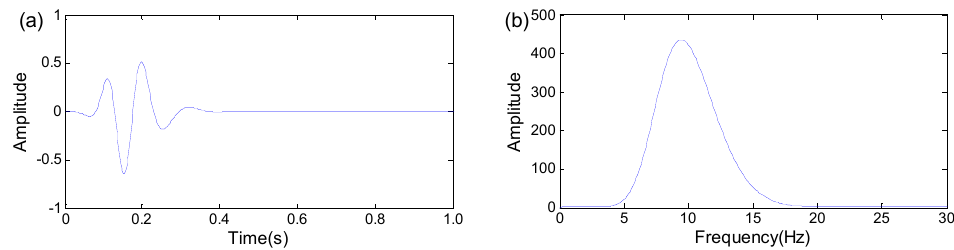
Figure 5. Source wavelet. ( a ) The waveform of the source wavelet. ( b ) The spectrum of source wave- let.